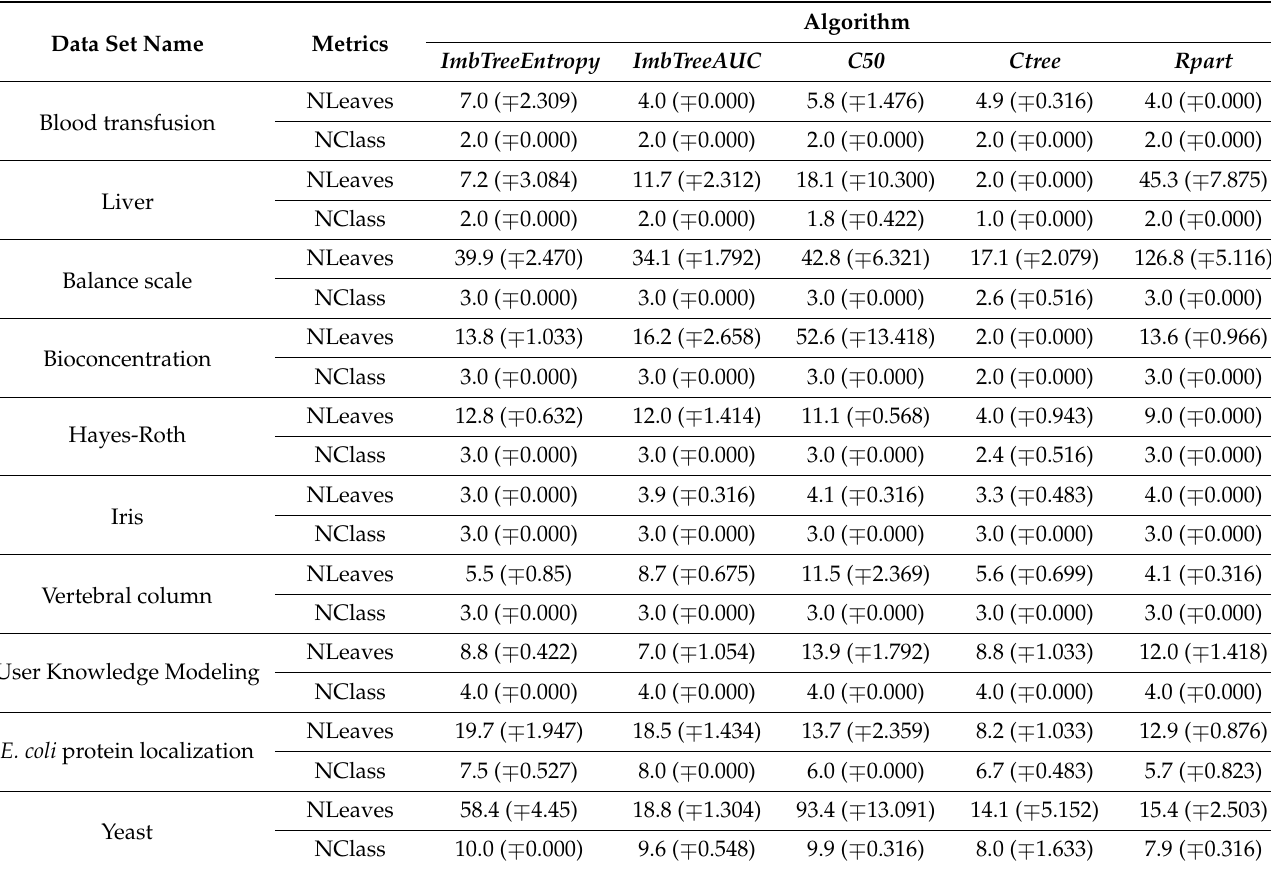
Table 3. Comparison of tree structures in terms of number of leaves and predicted